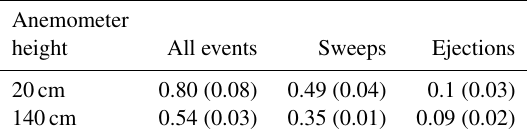
Table 2. Mean characteristic frequencies N 0 for turbulent events at both blowing snow site anemometers. The standard deviation of nightly means is shown in parentheses and indicates minimal changes between